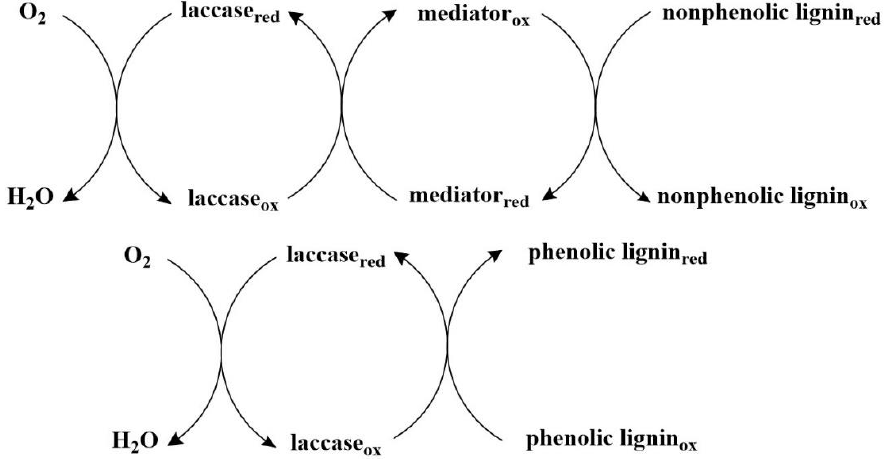
Figure 2 . Schematic representation of the catalytic mechanism of laccase. Laccase catalyzes the oxidation of reduced substrates with molecular oxygen, with or without the participation of an electron transfer mediator. The ‘’ox’’ refers to oxidized compounds, while “red” represents reduced compounds. The depolymerization of lignin requiring mediators is a common opinion